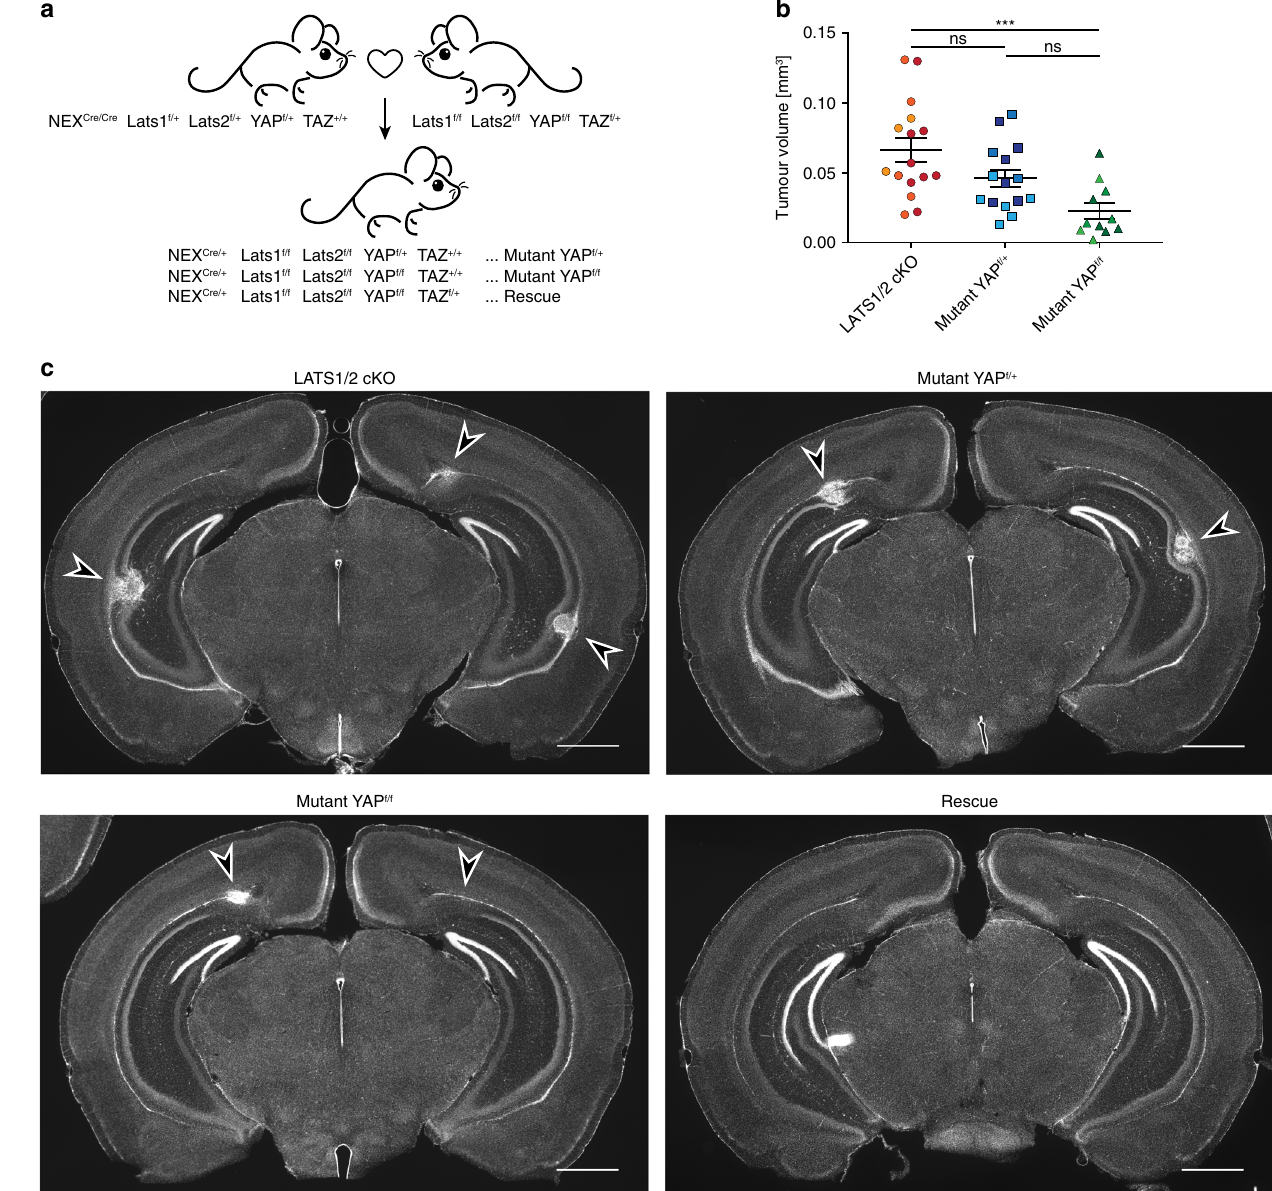
Fig. 4 YAP1 and TAZ are necessary for tumour development in LATS1/2 cKO mice. a Breeding scheme to generate a rescue model. Available animals (Lats1 f/f Lats2 f/f , YAP f/f TAZ f/ + and NEX Cre/Cre ) were crossed to generate mice with shown genotypes. b Measurements of size of tumours found in LATS1/2 cKO ( n = 16 tumours), Mutant YAP f/ + ( n = 15 tumours) and Mutant YAP f/f ( n = 11 tumours) from n = 3 mice for each genotype. Colour shade indicates tumours from the same animal. LATS1/2 cKO tumour volumes compared with those measured in Mutant YAP f/f animals show a signi fi cant difference with padj = 0.0006 (two-sided Dunn ’ s multiple comparison test). Error bars = SEM. c Coronal vibratome sections of P20 brains stained for DAPI. No tumour formation identi fi ed in Rescue mice. Tumours (arrowheads) can be found in LATS1/2 cKO, Mutant YAP f/f and Mutant YAP f/ + animals. Scale bars = 1